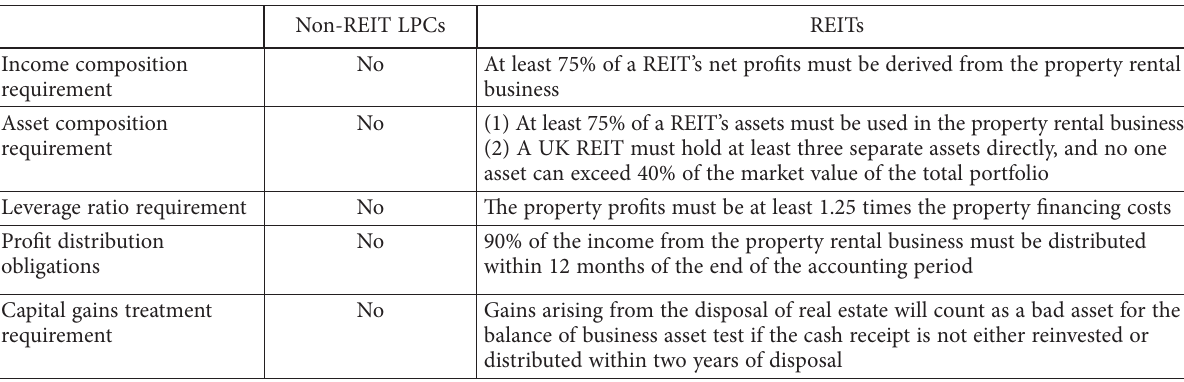
Table 1. Regulatory environment comparison between non-REIT LPCs and REITs in the UK Non-REIT